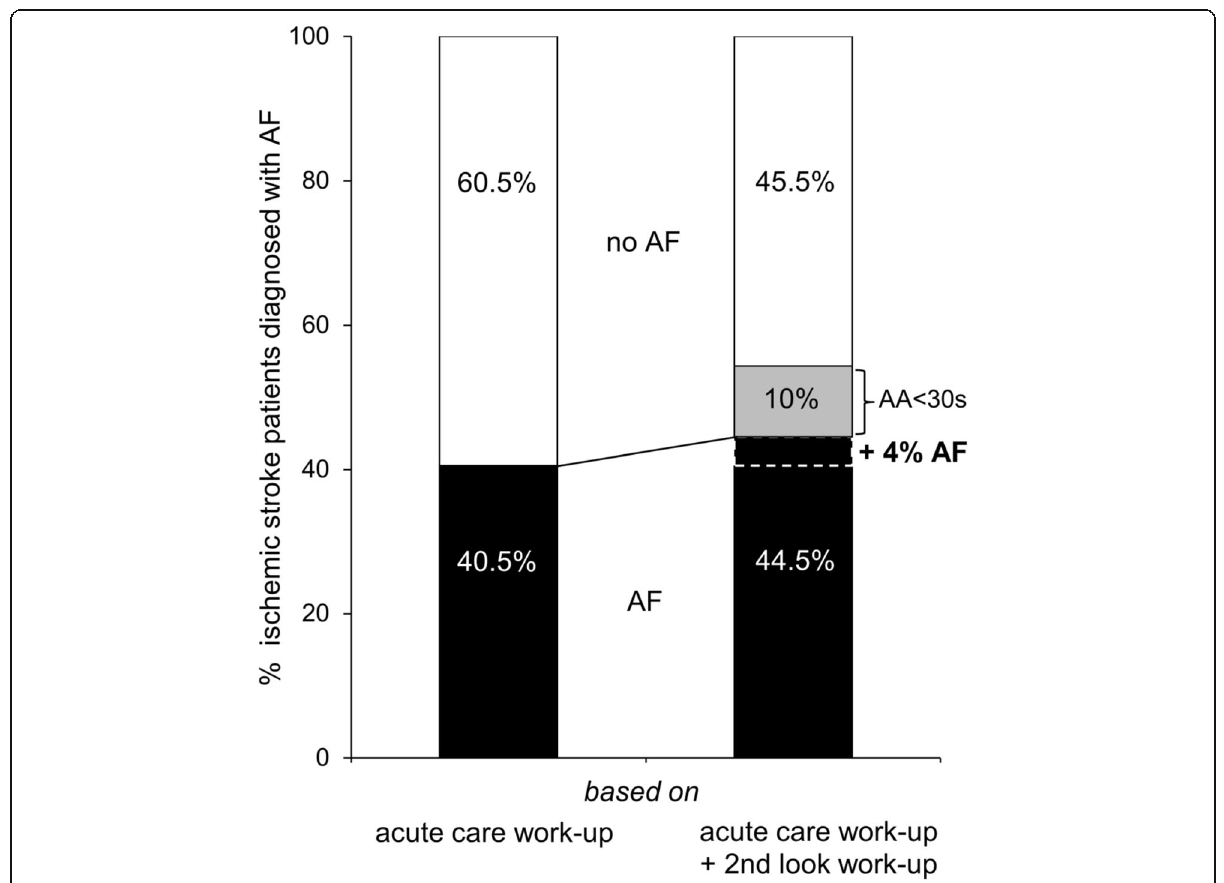
Fig. 2 Proportion of patients with ischemic stroke (total n = 508) diagnosed with AF based on acute care work-up alone (left) and based on both acute care work-up and post-acute second-look ECG performed during inpatient